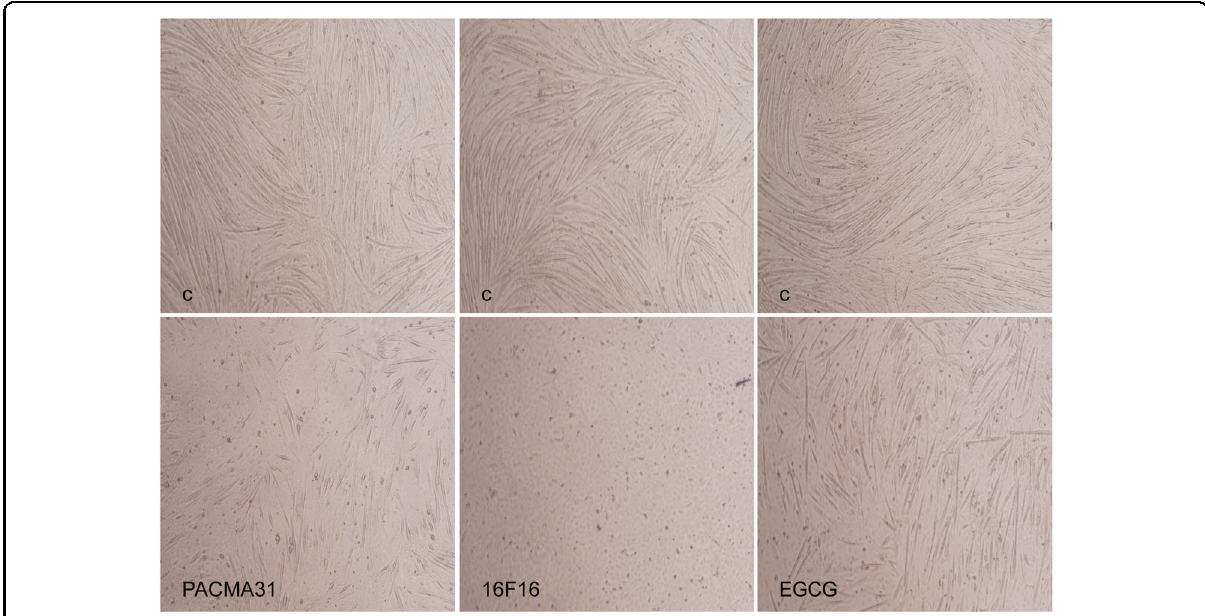
Fig. 5 The role of PDIA3 in myoblast fusion. C2C12 myoblasts were induced to differentiate for 48 h and were treated with PCAMA31, 16F16, and EGCG. After 72 h, myotube formation was observed by a microscope. Scale 200